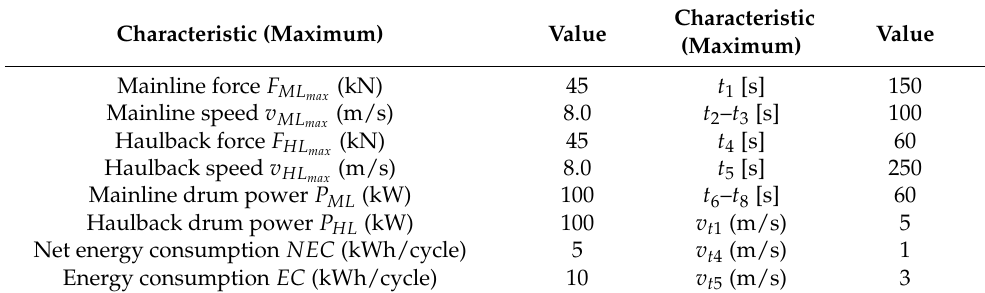
Table 6. Target performance characteristics of a five-ton hybrid tower yarder.